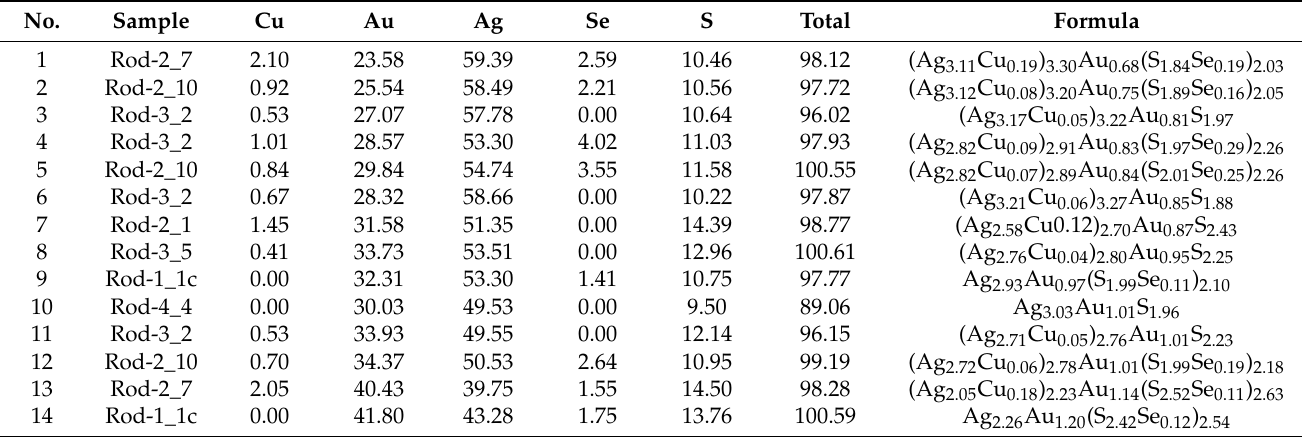
Table 5. Composition of minerals of the Au–Ag(Cu)–S(Se) system close to uytenbogaardtite composi- tion see Figure 6b, wt.%.